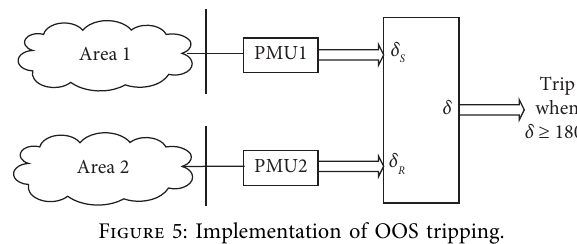
Figure 5: Implementation of OOS tripping.